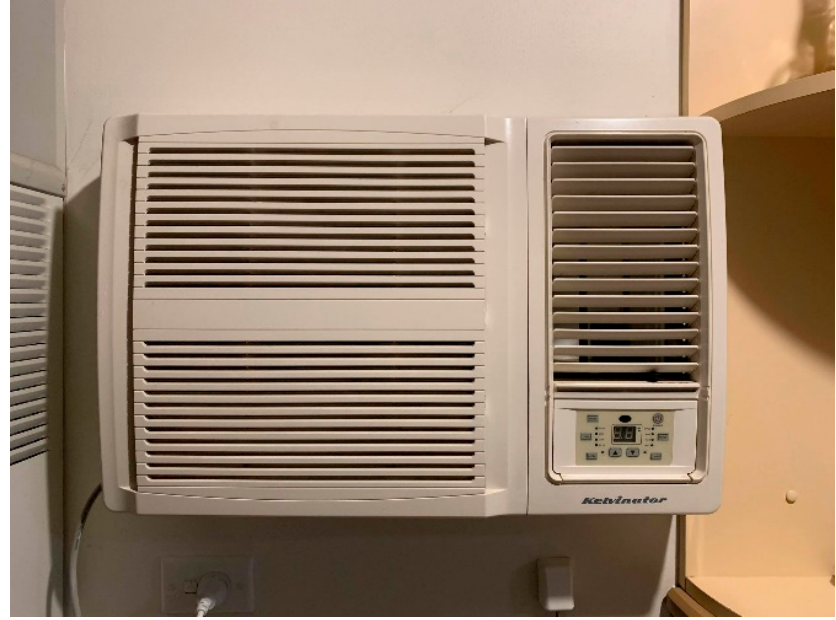
Figure 1. Wall-mounted direct expansion A/C. Source: First author.